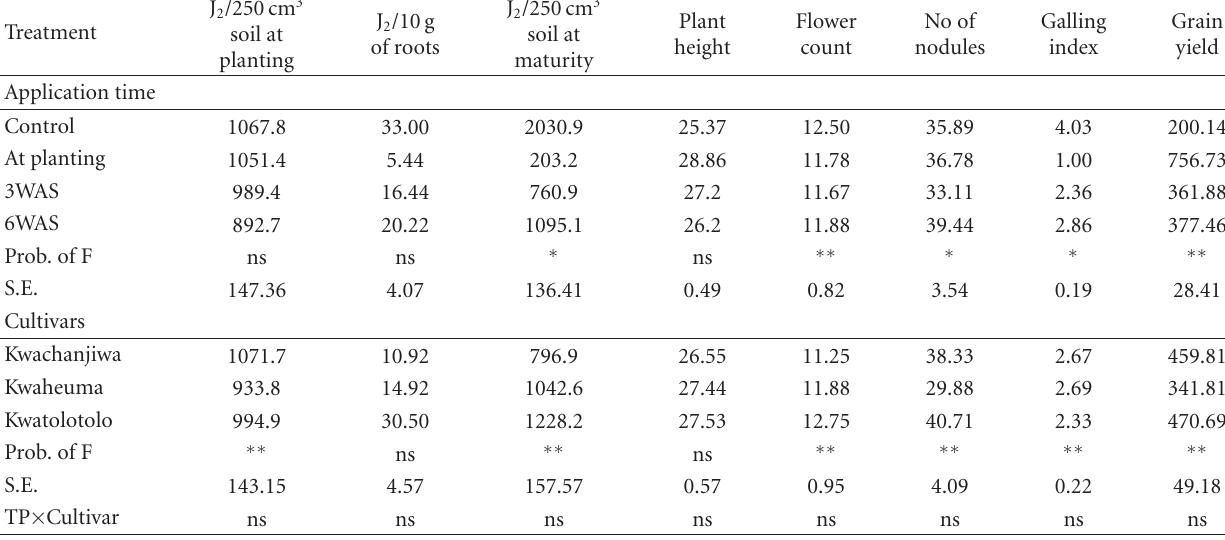
Table 2: Pooled means of the e ff ects of application of carbofuran to control M. javanica on the characteristics of M. javanica and the performance of bambara groundnut in 2002 and 2003 cropping seasons.